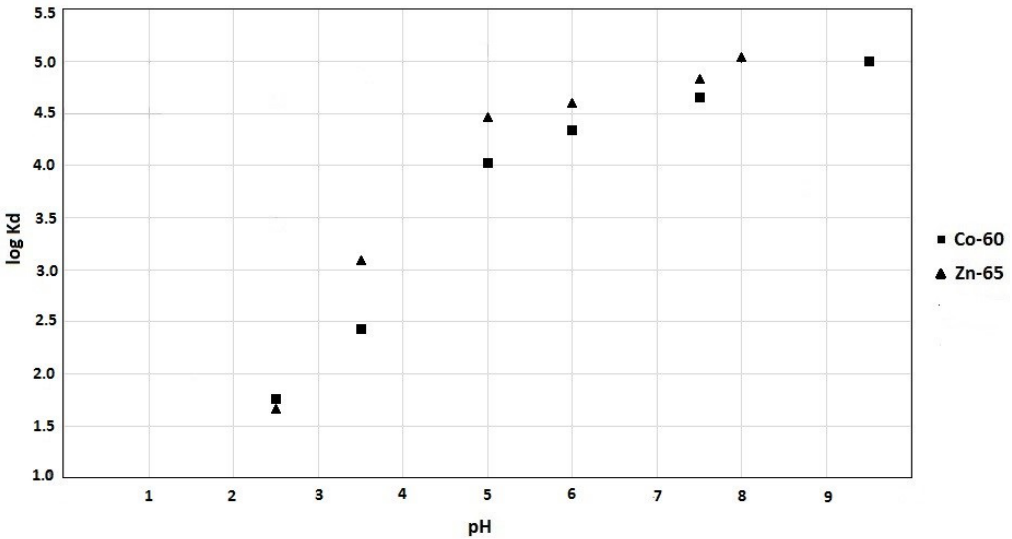
Figure 4. The dependence of 60 Co and 65 Zn distribution coefficients on solution pH.